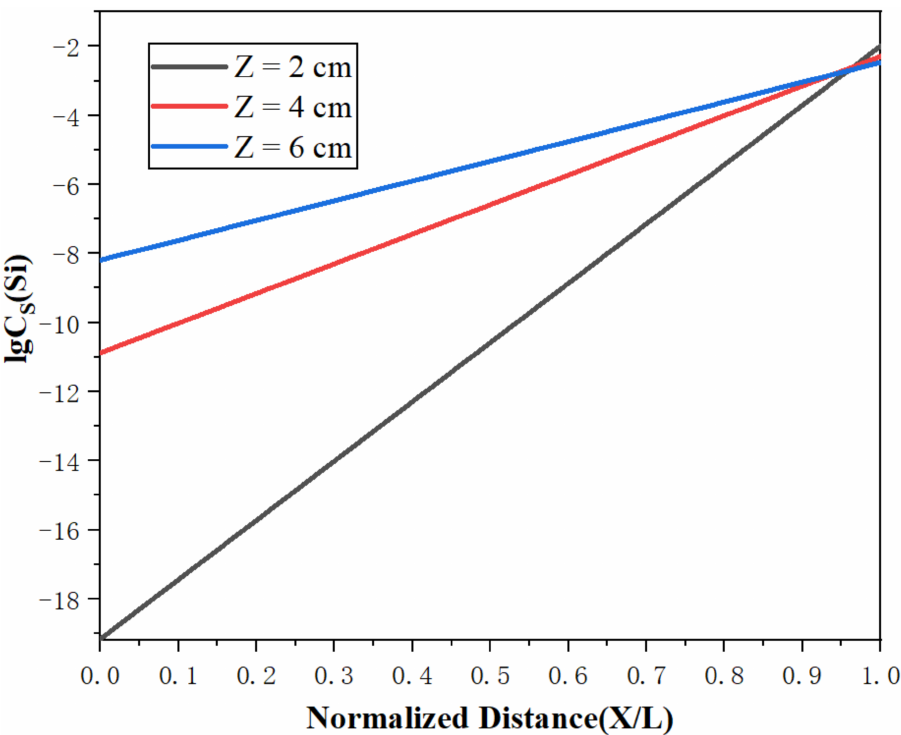
Figure 14. Limiting distribution of